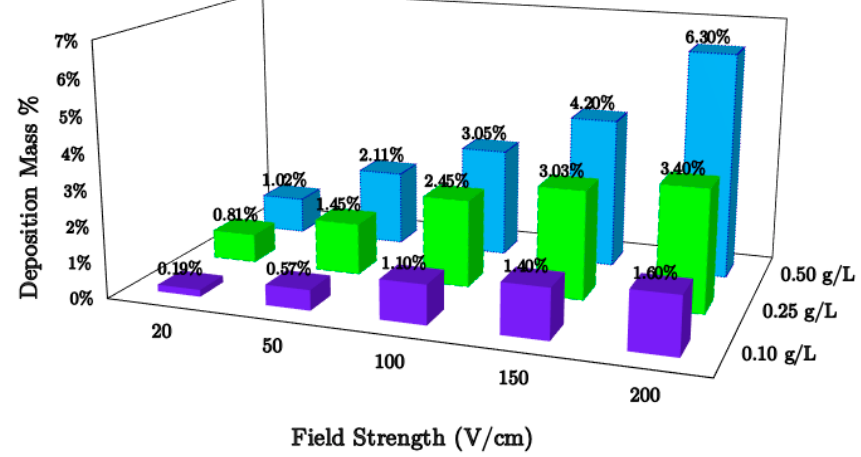
Figure 5. Effect of field and concentration on deposition mass in EPD of CNTs on GTs.